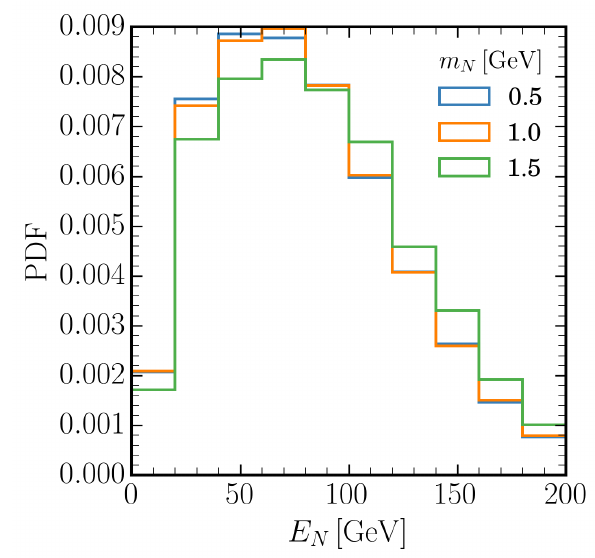
Figure 2: A histogram of the energy distribution of HNLs produced within the BEBC opening angle. Results are shown for three values of the HNL mass m the insensitivity to the mass until it approaches the production threshold of m τ